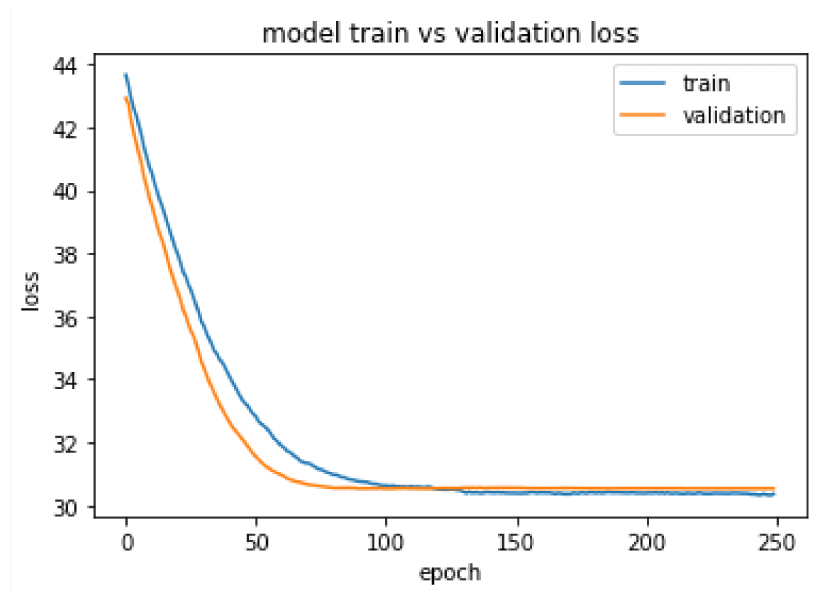
Figure 5. Evaluation of the training of the LSTM